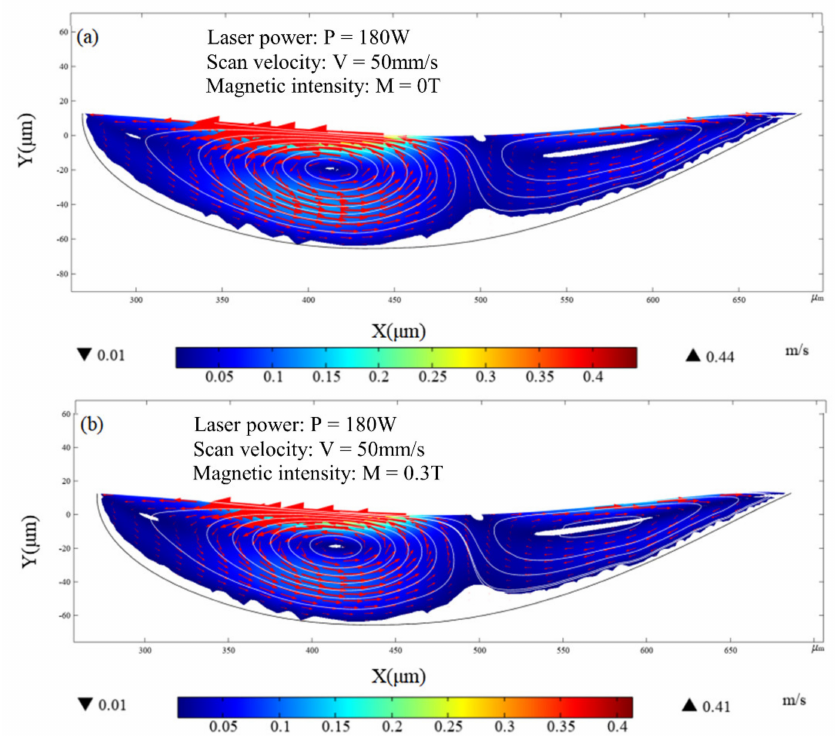
Figure 14. Velocity distribution of fluid in molten pool at t = 10 ms: ( a ) without magnetic field